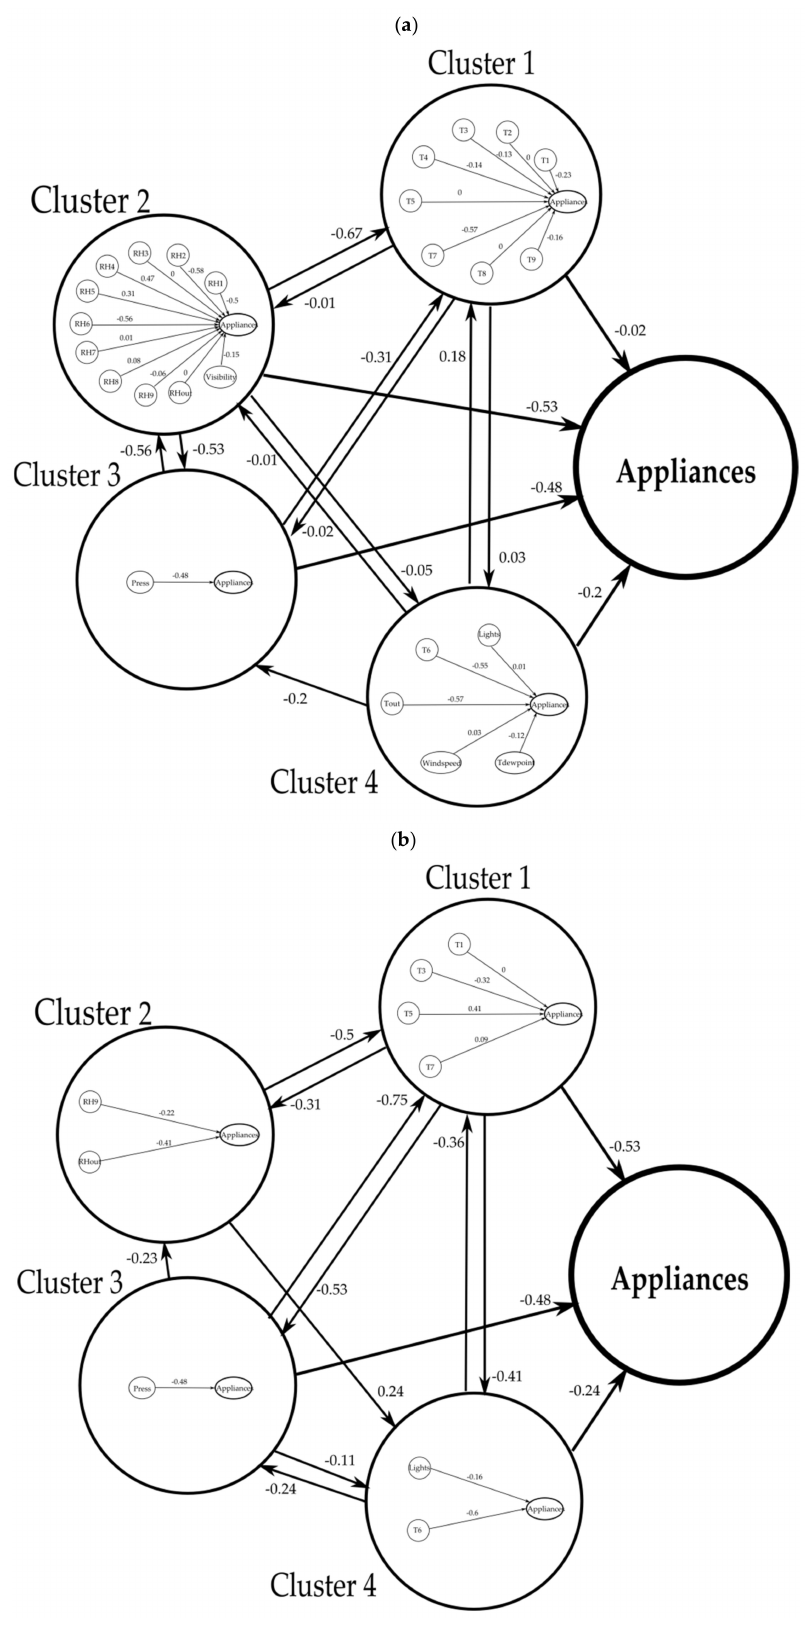
Figure 3. Sample nested fuzzy cognitive map obtained with the use of ( a ) real-coded genetic algorithm (RCGA) and ( b ) structure optimization genetic algorithm